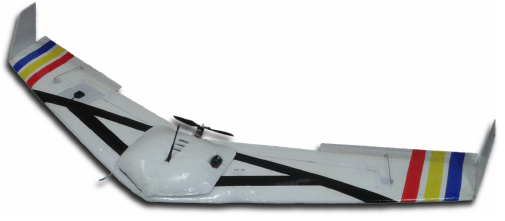
Figure 11. Picture of one of the UAVs used in the experiments.